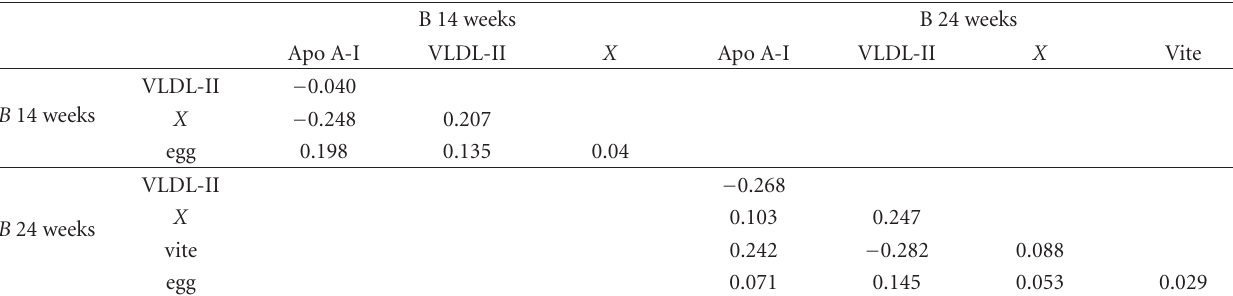
Table 6: The Pearson’s correlation coe ffi cient of B dataset is between serum protein concentrations apolipoprotein A-I, apo VLDL-II, X protein and Vitellogenin.